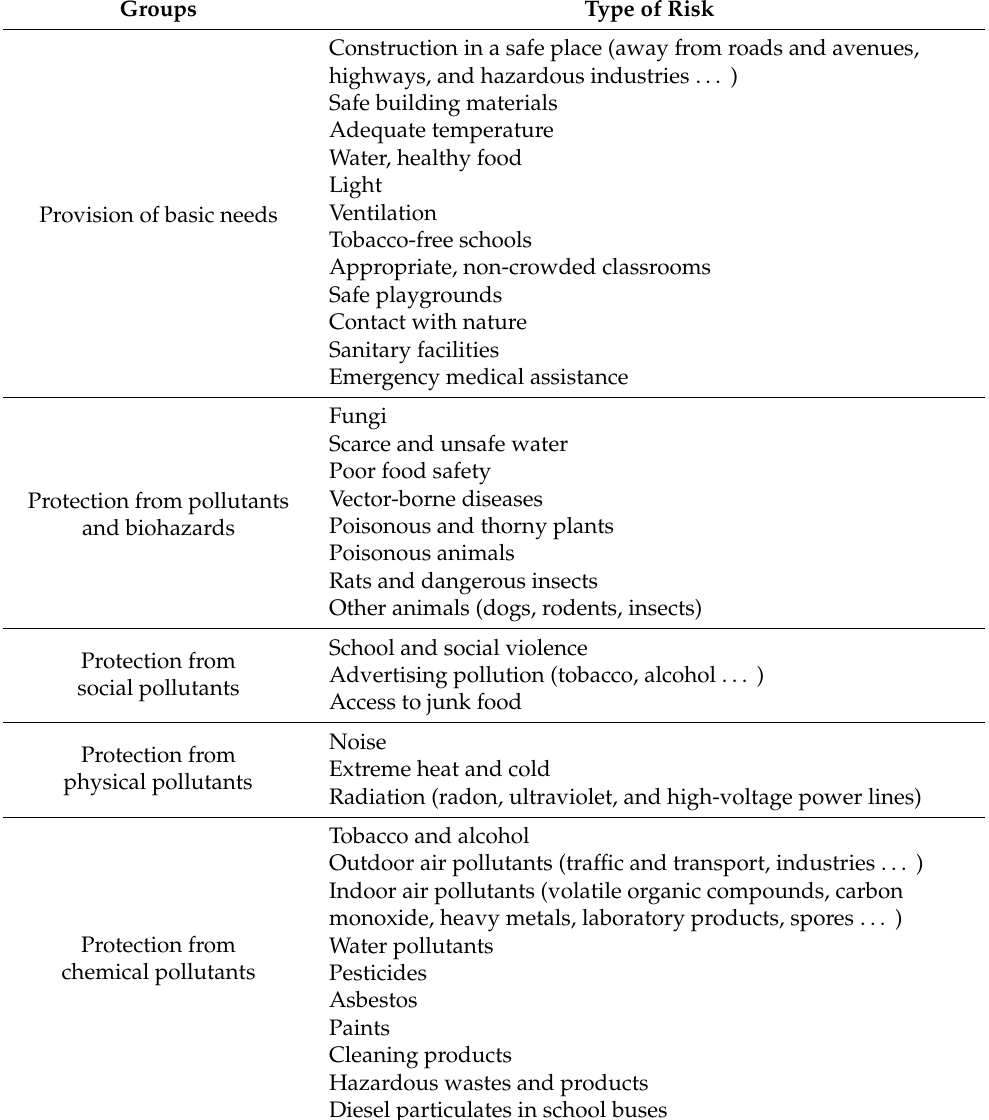
Table 1. Basic aspects to be addressed in school environmental health